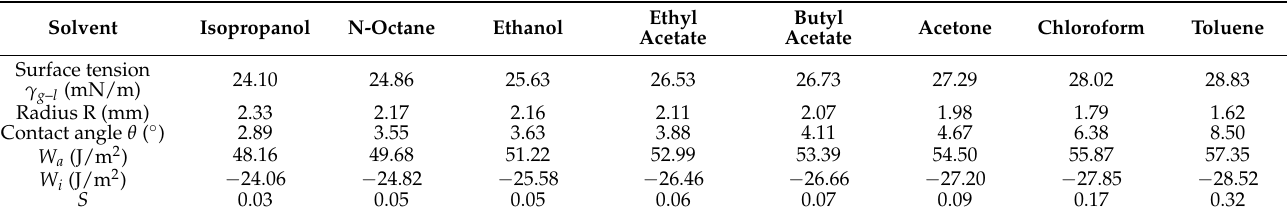
Table 3. Calculated values of droplet property parameters.